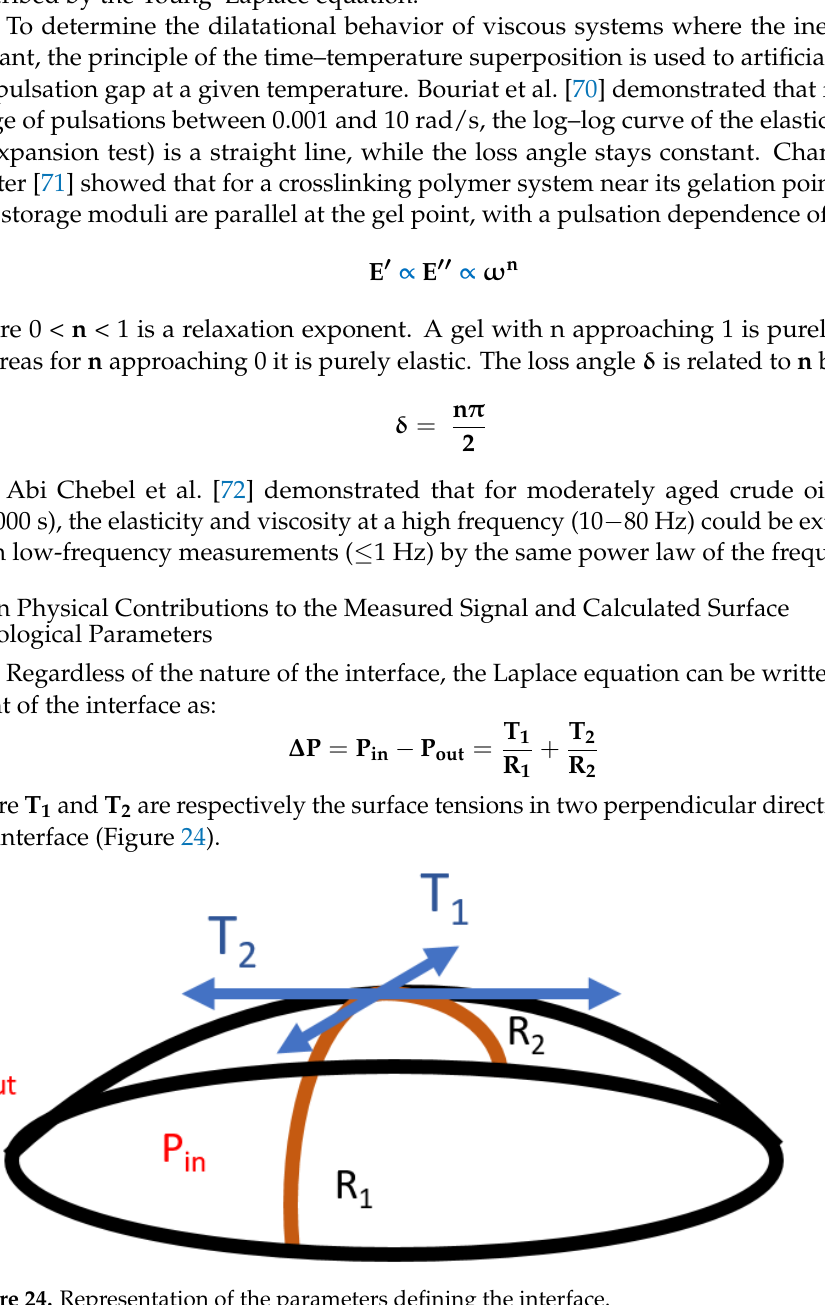
Figure 24. Representation of the parameters defining the interface.